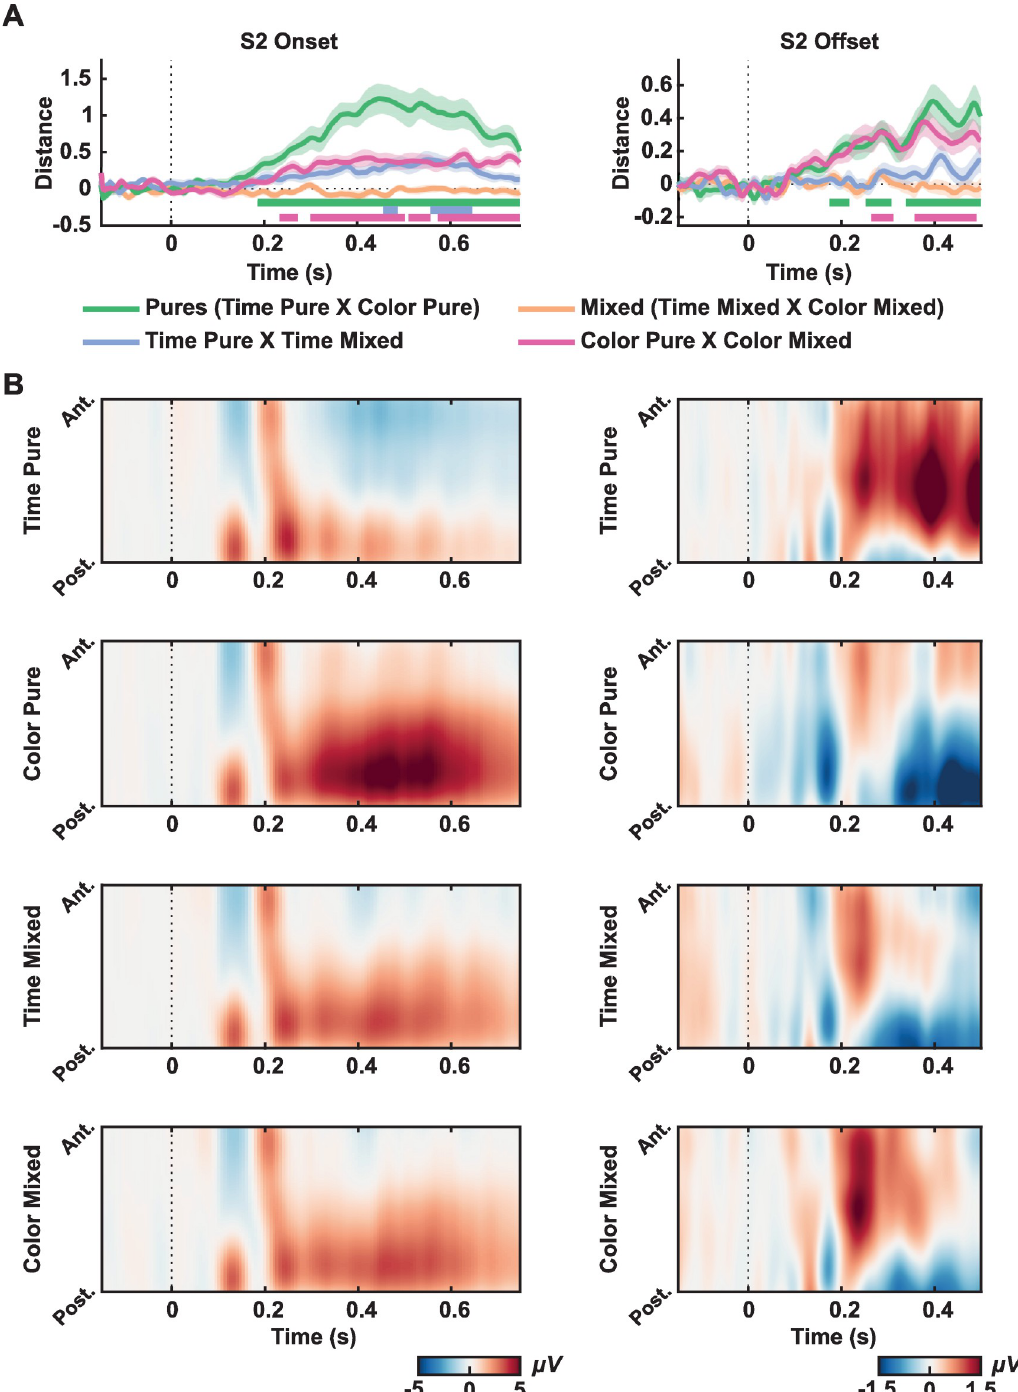
Fig 3. Decisional effects. (A) LDC distances between conditions for S2 onset (left) and S2 offset (right). Different colors indicate different comparisons. Shaded areas indicate the Standard Error of the Mean. Straight lines indicate significant windows for distances from the permutation test. (B) Spatial-temporal ERPs for each condition from S2 onset (right) and S2 offset (left). Graphs show the mean electrical potential between participants from a topographical organization of electrodes (anterior to posterior) in time. All electrodes were used for plotting, except for the reference ones (TP9 and TP10).